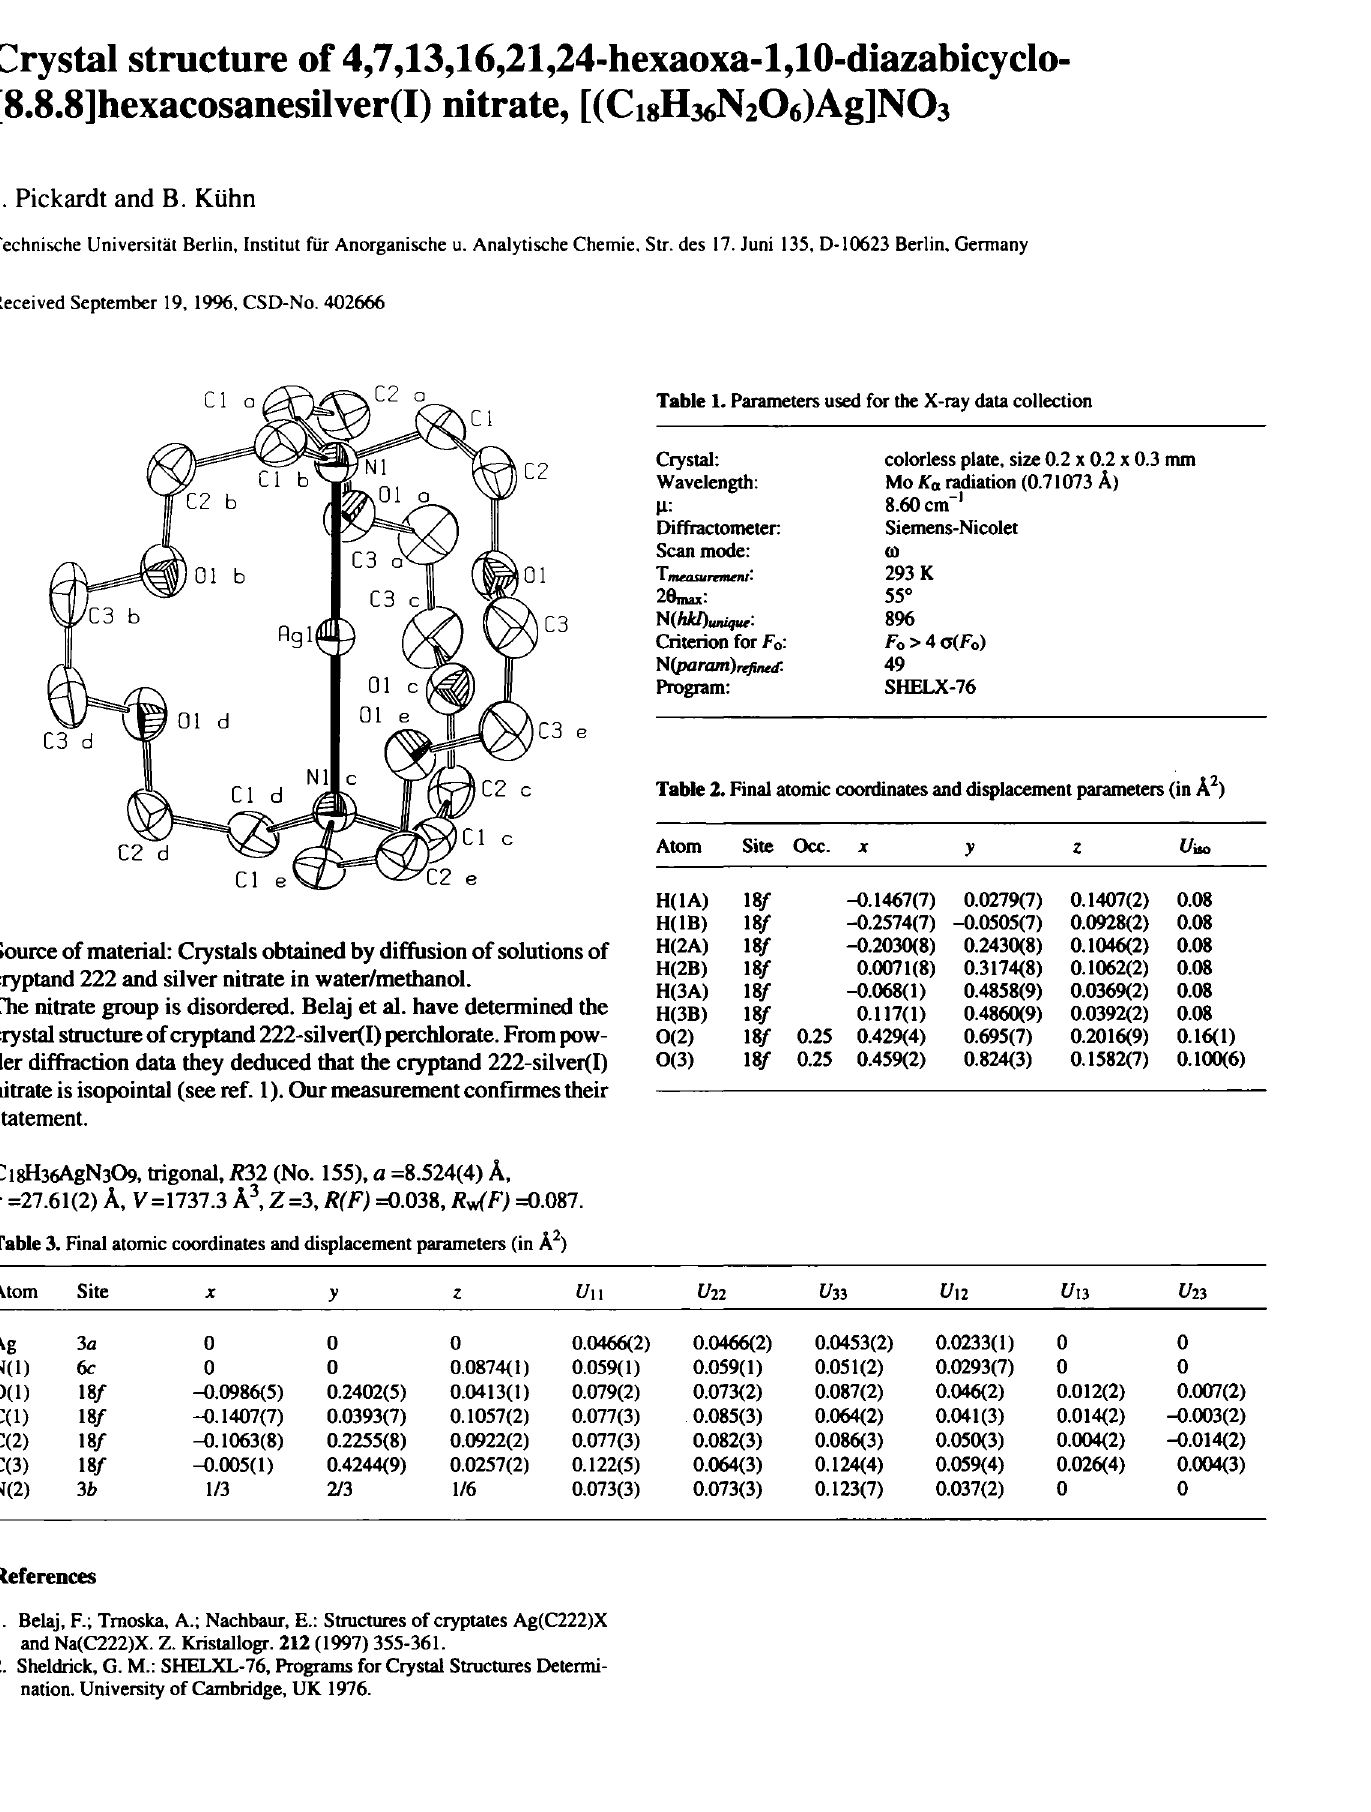
Table 2. Final atomic coordinates and displacement parameters (in Â 2 )